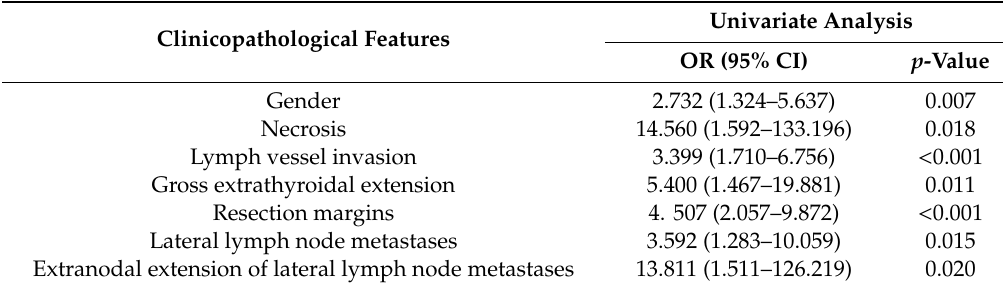
Figure 1. Kaplan–Meier curves of papillary thyroid cancer (PTC) recurrent / persistent disease status according to gender ( A ), lymph vessel invasion ( B ), necrosis ( C ), gross extrathyroidal extension ( D ) and resection margins ( E ), metastasized lateral lymph nodes ( F ), and extranodal extension of metastasized lateral lymph nodes ( G ). Table 1. Univariate analysis regarding recurrent / persistent disease.